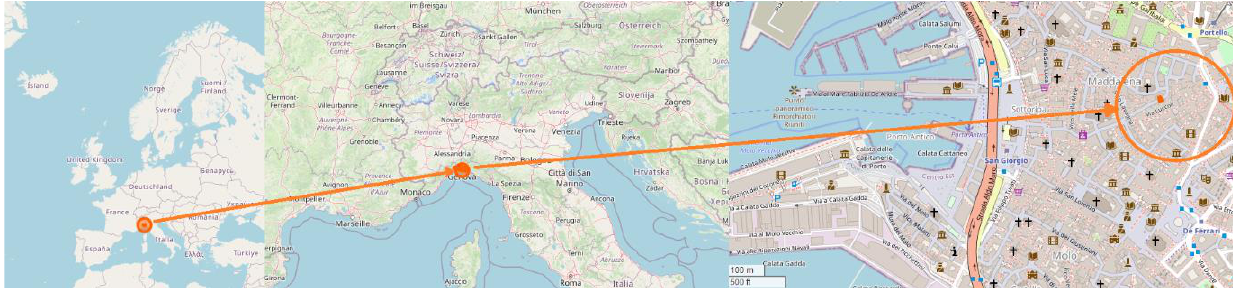
Figure 1. Localisation of the field (map based on OpenStreetMap cartography).